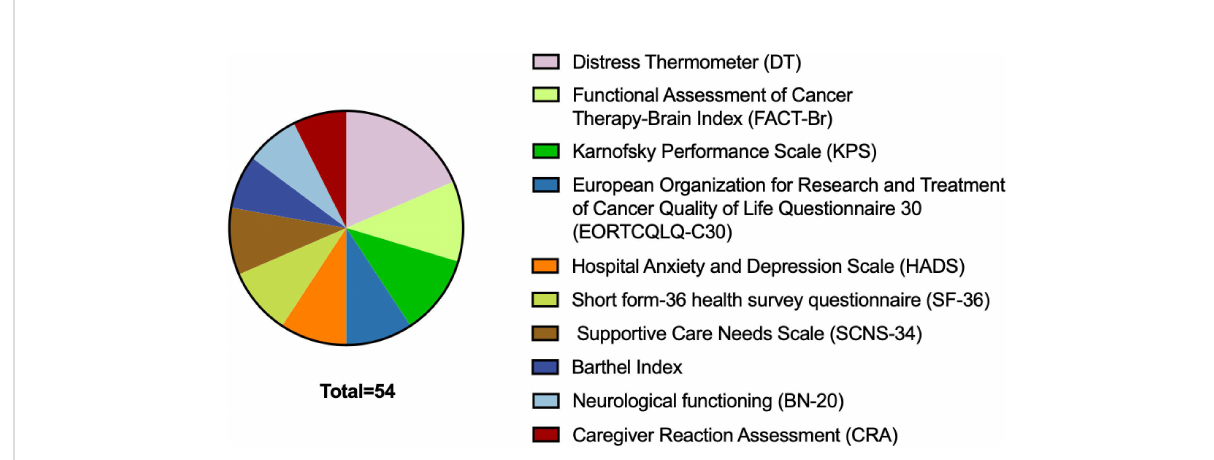
FIGURE 6 The top 10 scales used in quantitative